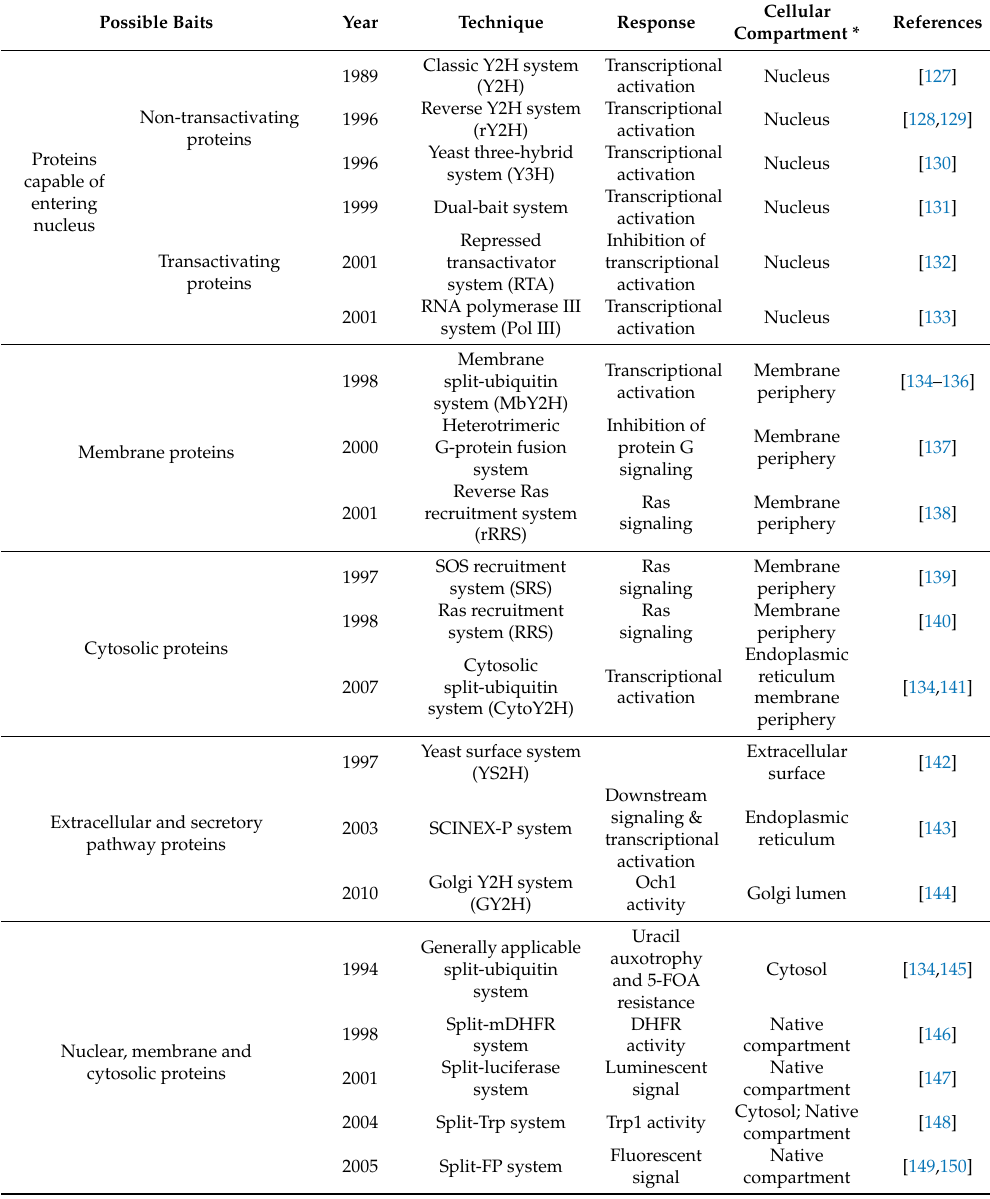
Table 2. Techniques for detecting protein–protein interaction in yeast (* Cellular compartment where the interaction takes